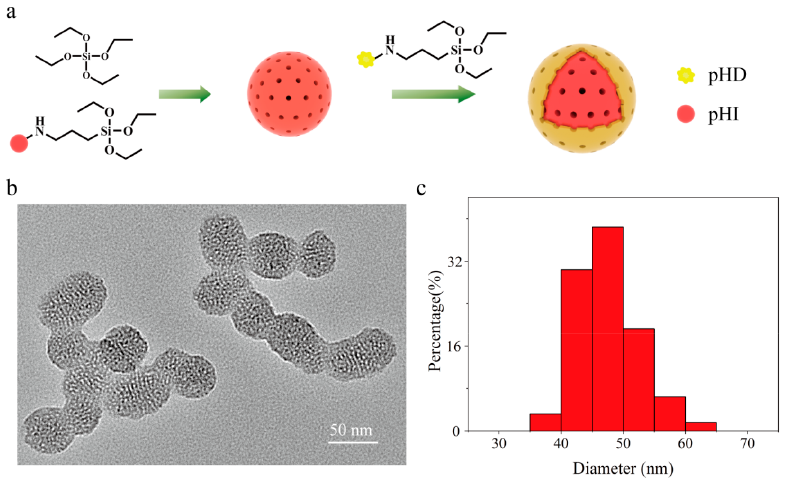
Figure 4. ( a ) The synthetic route, ( b ) the transmission electron microscopic image, and ( c ) the size distribution of the ratiometric pH nanosensors.